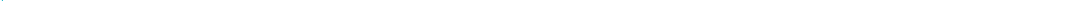
Figure 2: Relative deviation of per capita costs per day for drug claims in Swiss nursing homes compared with the Swiss average value of CHF 8.55, year 2016.FR, TI: not applicable (invoices for nursing care based on lump sums)AG = Aargau; AI = Appenzell Innerrhoden; AR = Appenzell Ausserrhoden; BE = Bern; BL = Basel-Landschaft; BS = Basel-Stadt; FR = Freiburg; GE = Genf; GL = Glarus; GR = Graubünden; JU = Jura; LU = Luzern; NE = Neuenburg; NW = Nidwalden; OW = Obwalden; SG = St. Gallen; SH = Schaffhausen; SO = Solothurn; SZ =